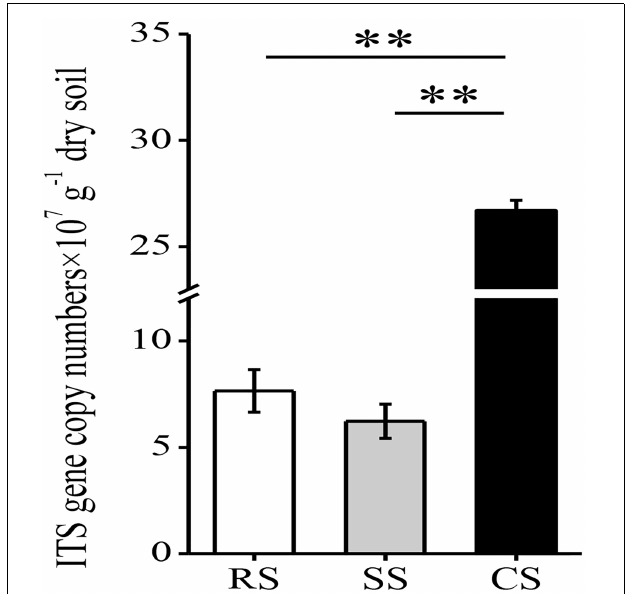
FIGURE 1 | The abundance of fungal ITS rRNA gene copies assessed by real-time PCR in three soybean cropping systems. ∗∗ P < 0.01 by Duncan’s test. RS, SS, and CS represented soybean rotation with a 3-year cycle of wheat, maize and soybean, short-term continuous soybean cropping with one-year wheat and two-year soybean, and long-term continuous soybean cropping,